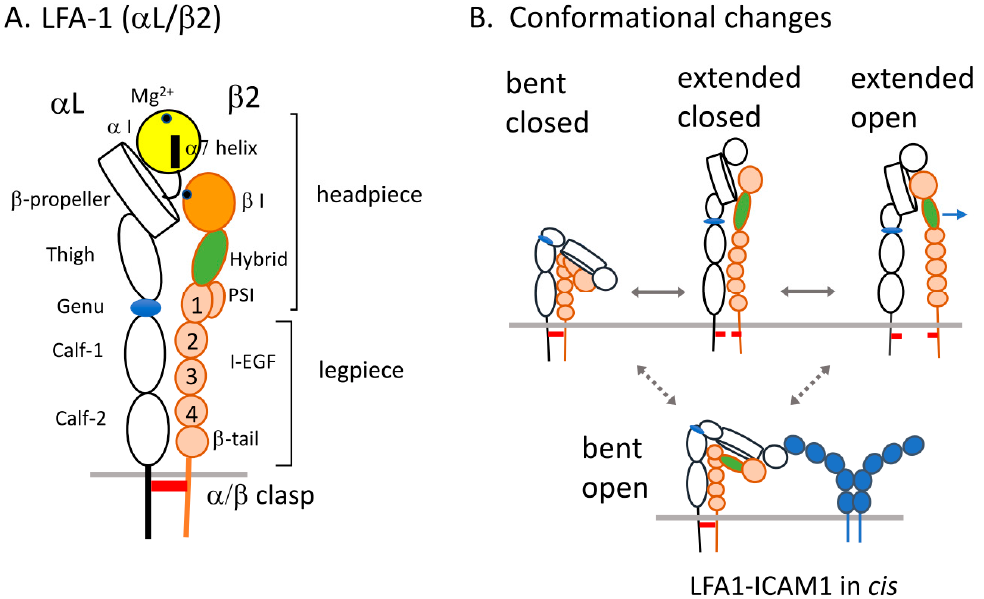
Figure 1. LFA1 structure and conformational changes. ( A ). LFA1 ( α L/ β 2). The ectodomains of α L and β 2 subunits are schematically shown in the extended conformation. The headpiece contains a ligand binding α I domain on top, β -propeller, and thigh domains in the α L subunit and regulatory β I and hybrid domains, and I-EGF1 in the β 2 subunit. Mg 2+ binding sites (dot) in α I and β I with the α 7 helix and intrinsic ligand-containing loop are shown. The legpiece contains calf-1 and calf-2 in the α L and I-EGF2-4 in the β 2. An inter-subunit association is depicted ( α / β clasp). ( B ). Conformational changes of LFA1. Three classes of conformations are characterized by bending and extension of the ectodomain and headpiece closed-open conformations. The ectodomains are bent in a region (genu) between the thigh and calf-1 in the α L subunit, and between the I-EGF1 and I-EGF2 domains in the β 2 subunit with a closed headpiece conformation. Upon stimulation or ligand binding, the bent-closed conformation is converted into extended-closed and extended-open conformations through positional changes of the hybrid domain (arrows representing hybrid domain swing-out into the open conformation). The bent-open conformation, discovered in slow rolling of neutrophils, is also shown.